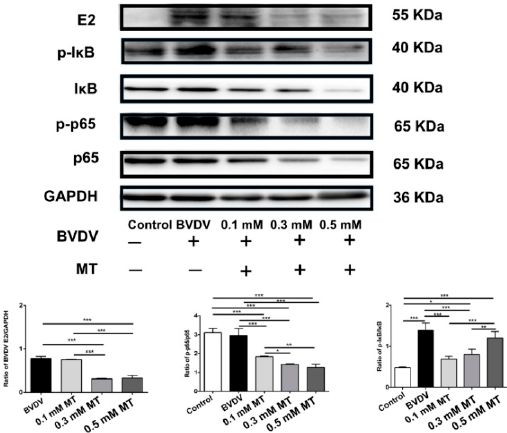
Figure 1. The comparison of the NF- κ B related protein expressions in MDBK cells. Relative protein expression levels were based on western blot band intensity; protein levels of p-p65, p-I κ B, E2 were normalized, respectively, with p65, I κ B, GAPDH. Representative western blot image of NF- κ B p-p65, p-I κ B, E2, p65, I κ B, GAPDH expression levels in the total protein of cells. The values in each column represent the mean ± SEM of three individual experiments detected in triplicate. * p < 0.05; ** p < 0.01; *** p <